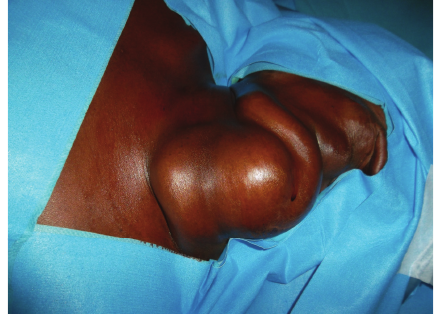
Figure 5: Preoperative view of the AVM exposed before surgical